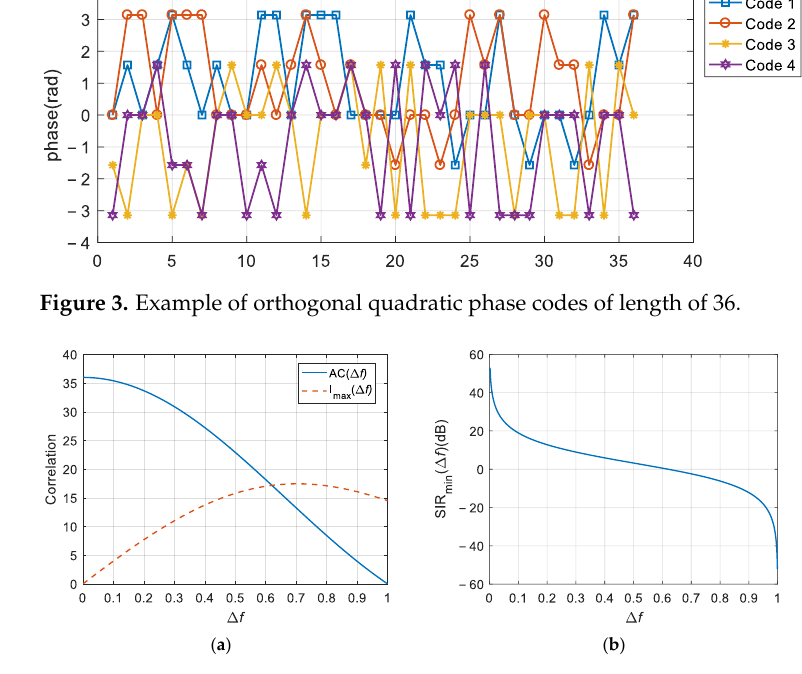
Figure 4. Performance degradation of orthogonal code by filter mismatch. ( a ) AC and CC according to doppler mismatch ( b ) Minimum SIR.